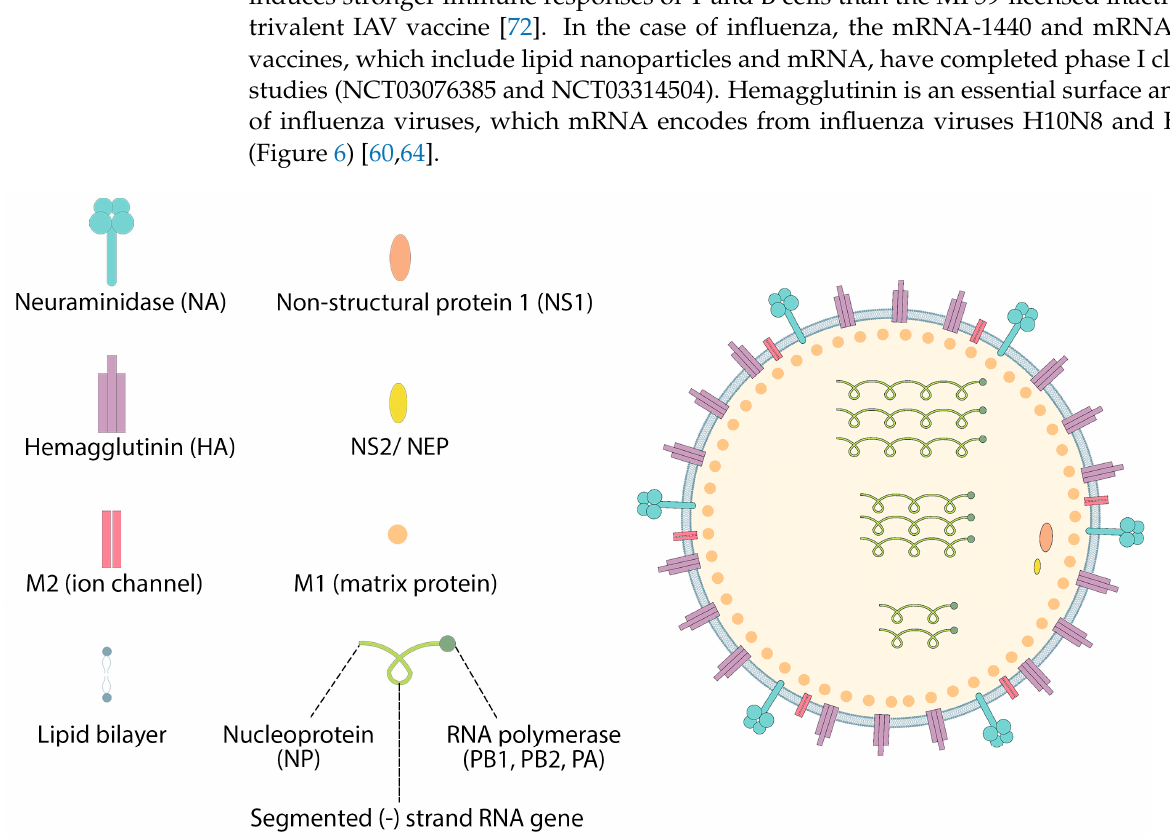
Figure 6. Structure of influenza